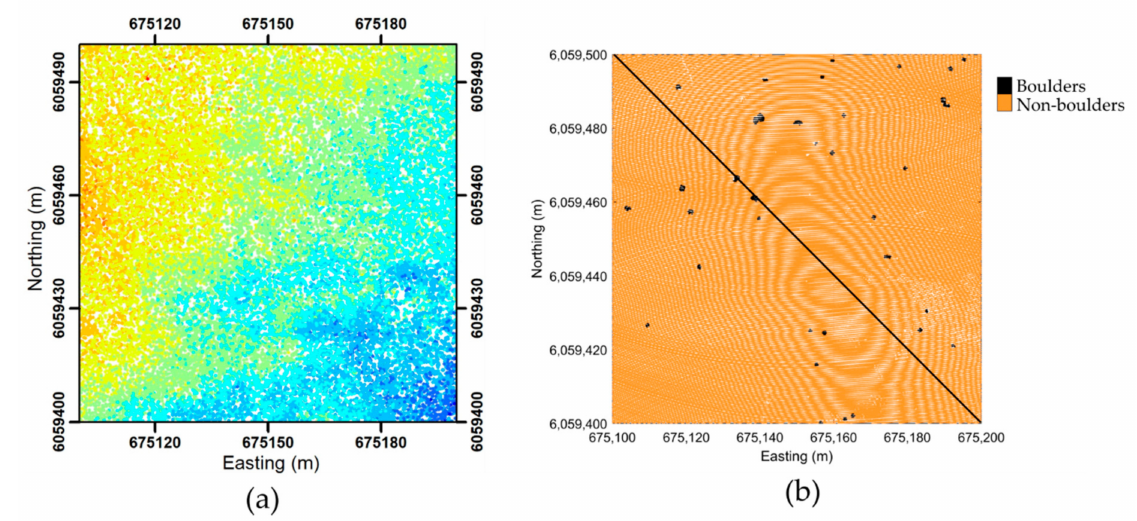
Figure 7. ( a ) Point cloud of the study area colored by depth. ( b ) Point cloud with boulder (black)/non-boulder (orange) classification divided into training set (left half) and test set (right half). Projection is in ETRS89 UTM Zone 32N with units in